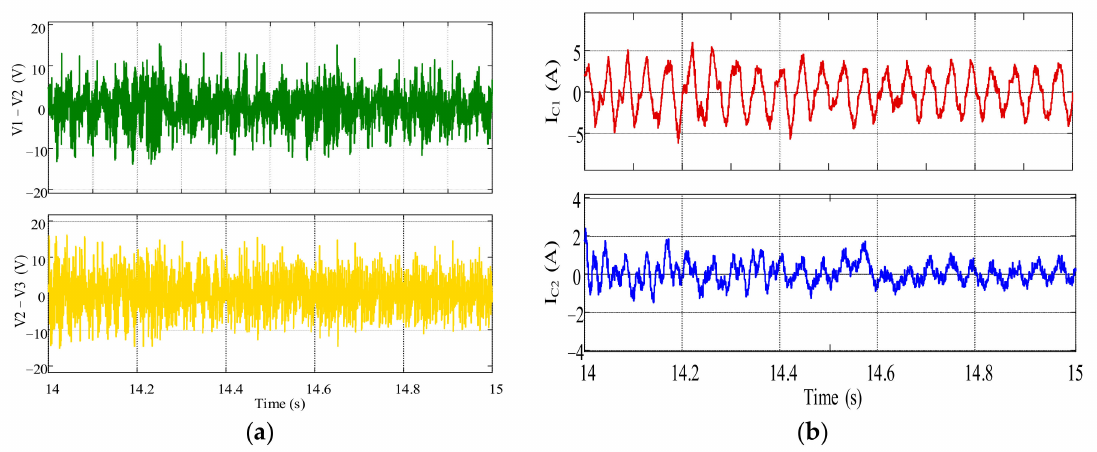
Figure 11. The zoomed-in voltage differences ( a ) and circulation currents; ( b ) in the steady state when they were connected with the traction grid without a load with the proposed